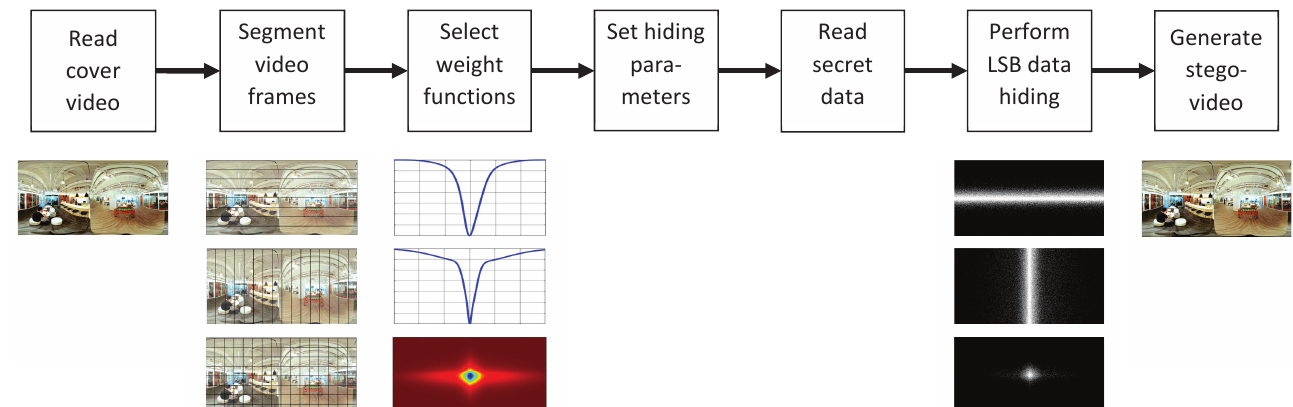
Figure 3. Block diagram of the basic components of the proposed viewing direction based LSB data hiding for 360 ◦